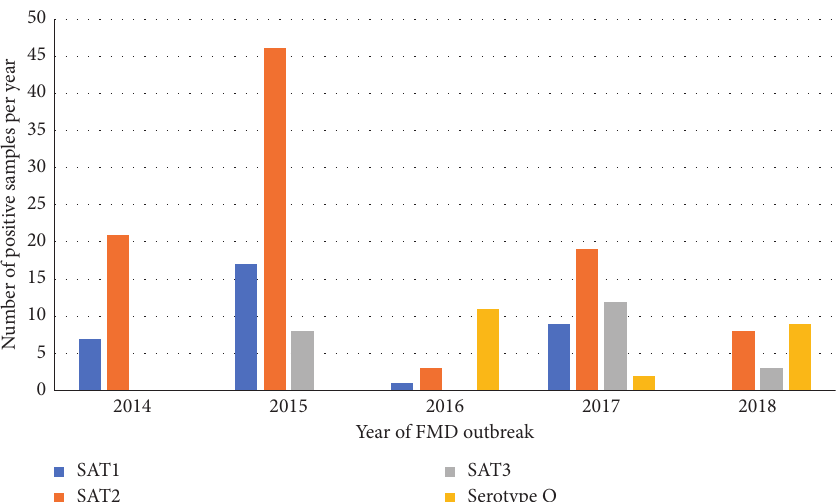
Figure 1: Annual distribution of foot-and-mouth disease (FMD) positive bovine samples by FMDv serotype observed in southern Africa, 2014–2018.